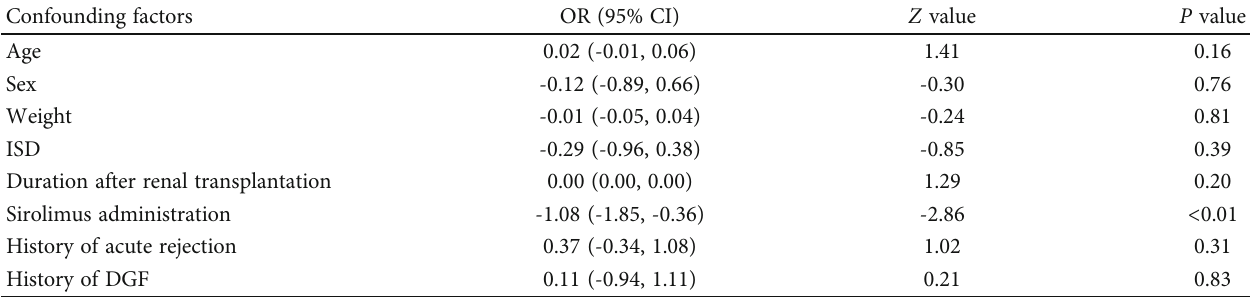
Table 3: In fl uence of confounding factors on the outcomes of graft fi brosis by general linear model.